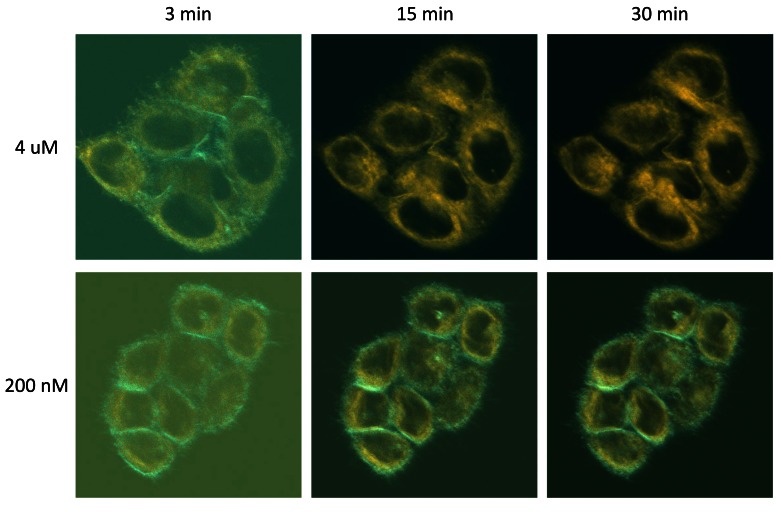
High concentrations of C-laurdan can result in autoquenching at the plasma membrane.Hela cells growing on coverslips were placed in observation chambers in 1 ml of serum-free medium and placed in the thermostatic chamber of the biphoton microscope. After focusing on a chosen group of cells, C-laurdan was added to a final concentration of either 4 µM (top panels) or 200 nM (bottom panels). Lambda stack images were then taken at the indicated times, with the laser power set at 2% for staining with 4 µM, and 4% for 200 nM C-laurdan. All other settings were as described in Methods and spectral decomposition was carried out as described in Methods. The pictures shown are dual-colour overlays. Cyan, C-laurdan in apolar environments; orange, C-laurdan in water-exposed environments. The duller aspect of the pictures taken at 3 minutes is due to the fact that, at this early time point, the probe had not had time to stain the cells fully, resulting in low signal to noise ratios.